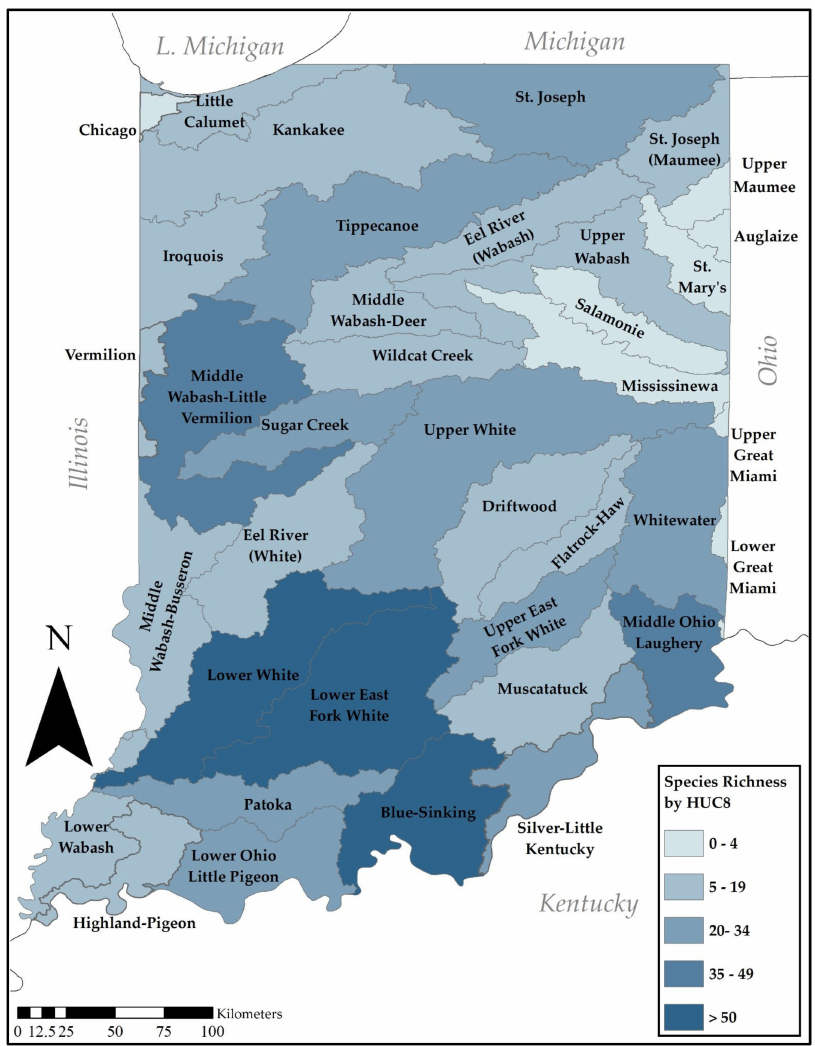
Figure 6. Heat map of Plecoptera species richness within HUC8 watersheds in Indiana. A K-means cluster analysis of HUC8 species assemblages produced two